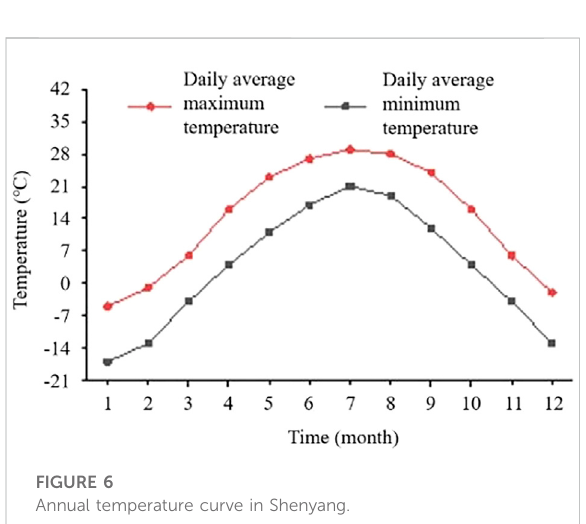
FIGURE 5 Trabecular specimen.